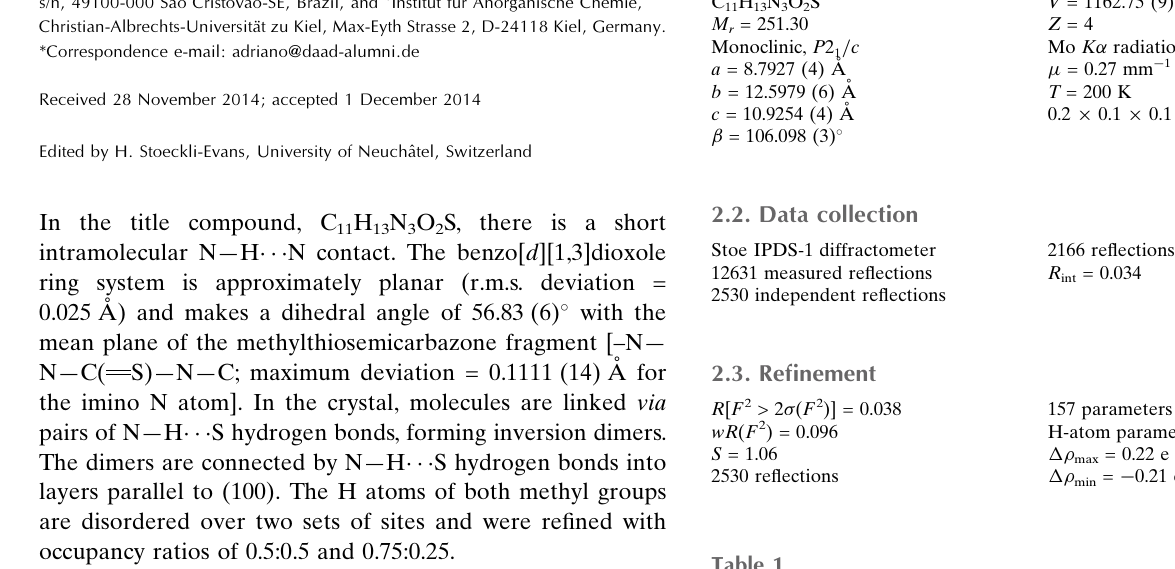
Hydrogen-bond geometry (A˚ , (cid:3)